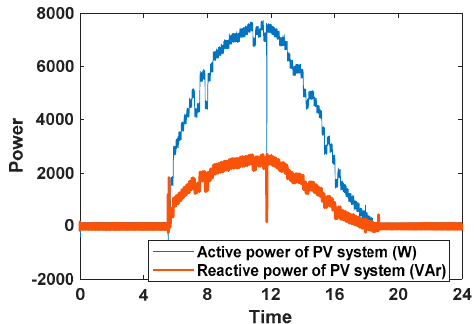
Figure 10. The energy profile of the photovoltaic (PV) system in 24 h. Energies 2020 , 13 , x FOR PEER REVIEW